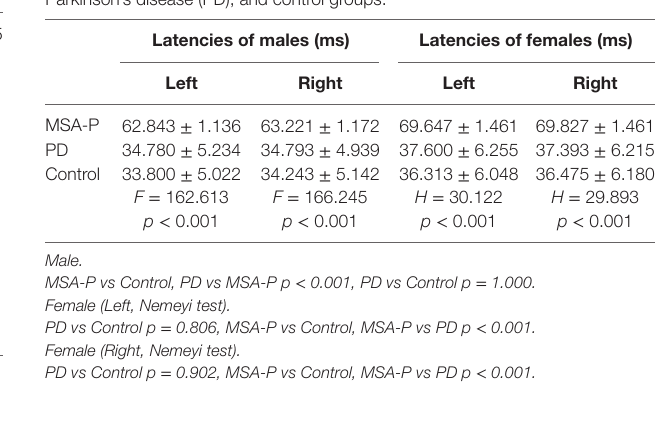
TaBle 1 | General characteristics and elicitation rates of the bulbocavernosus reflex (BCR) latencies between multiple system atrophy with predominant parkinsonism (MSA-P), Parkinson’s disease (PD), and control groups. TaBle 2 | Comparison of the mean or median bulbocavernosus reflex latencies between multiple system atrophy with predominant parkinsonism (MSA-P), Parkinson’s disease (PD), and control